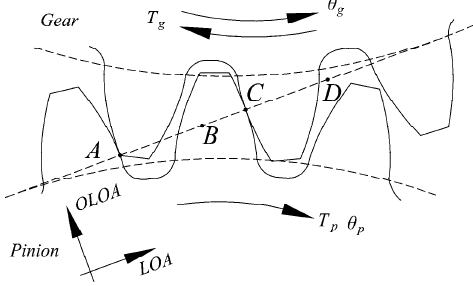
Figure 7. A snapshot of the contact pattern (at t = 0) of a spur gear pair.